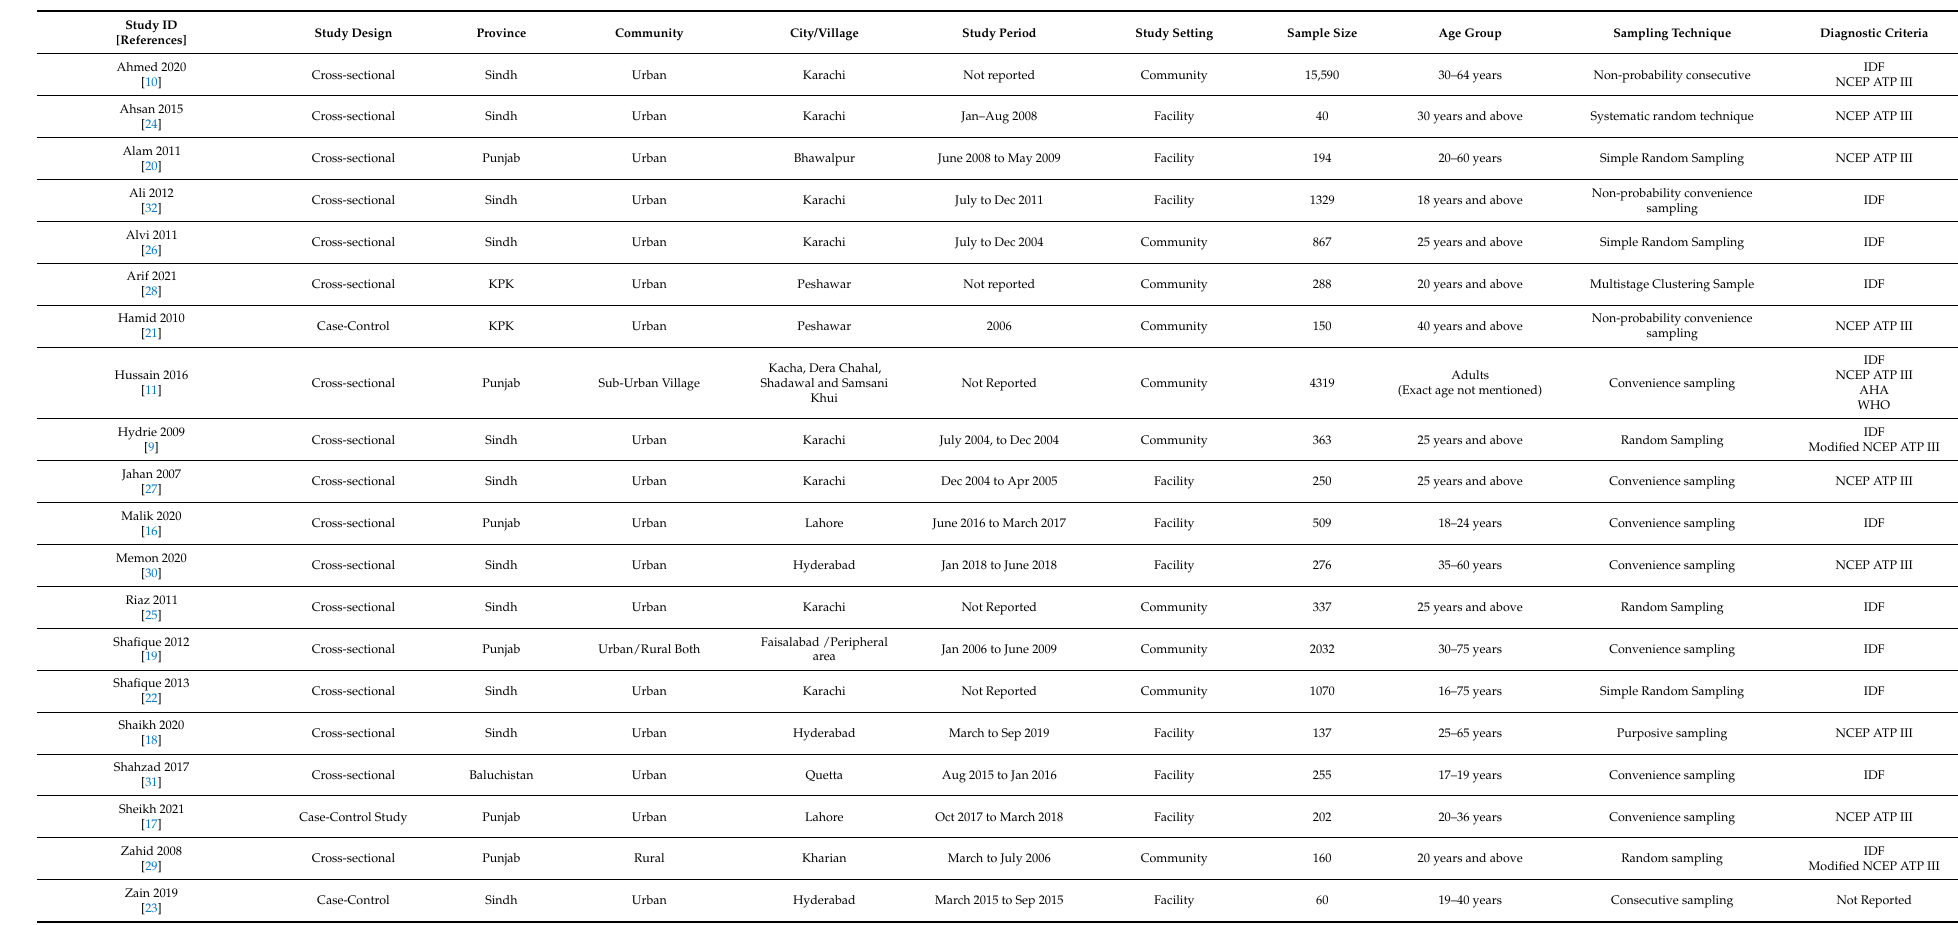
Table 1. Major Characteristics of the Included